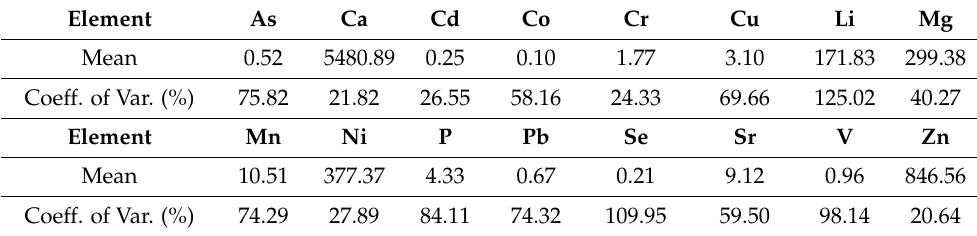
Table 2. Concentrations of elements ( µ g L − 1 ) summarized for the rainfall events occurring